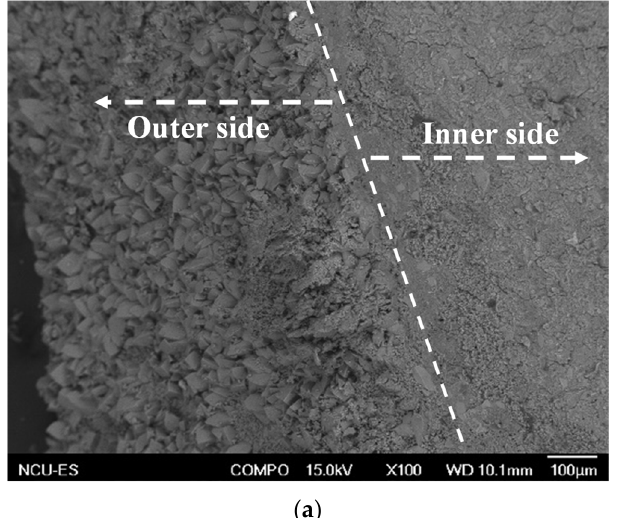
Figure 6. Expansion of mixture mortars with different CFB fly ash/SBM ratios under external sulfate attack.